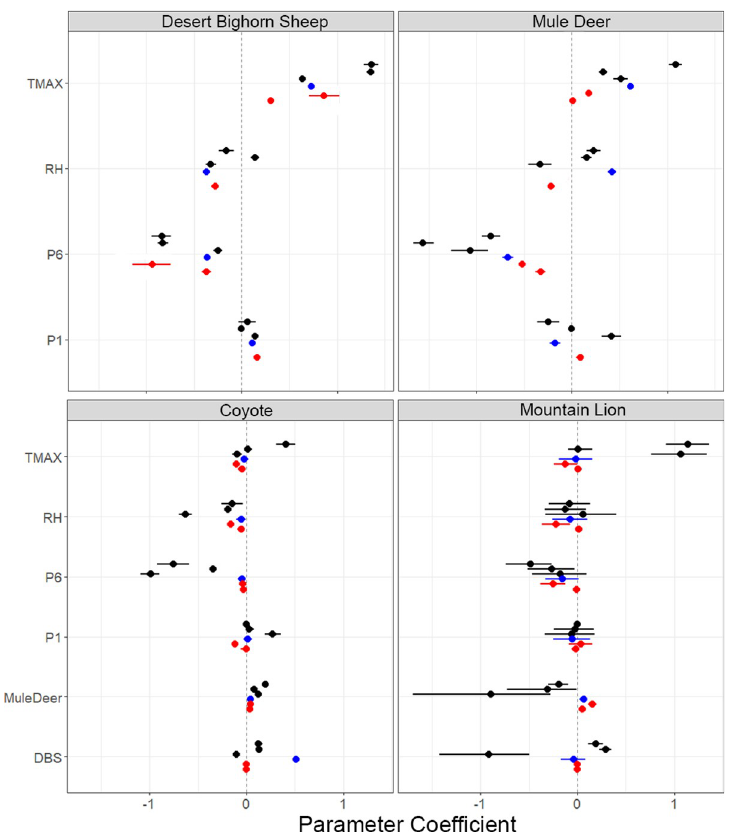
Fig 3. Slope parameters and 95% credibility intervals. Results from multi-species, multi-site models predicting species visits to water catchments within three southwestern deserts of the United States (Chihuahan:red; Mojave:blue; Sonoran:black). For each desert, increases in maximum temperature (TMAX; weekly average of daily maximum temperature) and declines in long-term precipitation (P6: weekly sum of precipitation within a week and the prior 5 weeks) raised visits for mule deer and desert bighorn sheep. RH indicates the weekly average of daily minimum relative humidity, and declines in RH associated with more visits to water by coyotes. Visits to water by mountain lions also increased with declines in long-term precipitation. Visits to water by prey were inconsistent predictors of visits to water by mountain lions. P1 represents the weekly sum of precipitation.